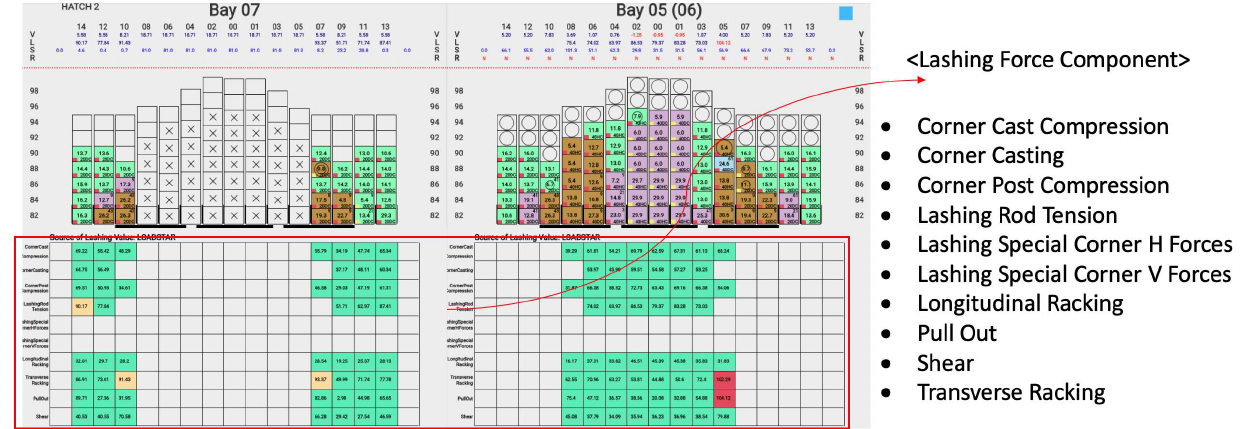
Figure 7. Lashing force components.